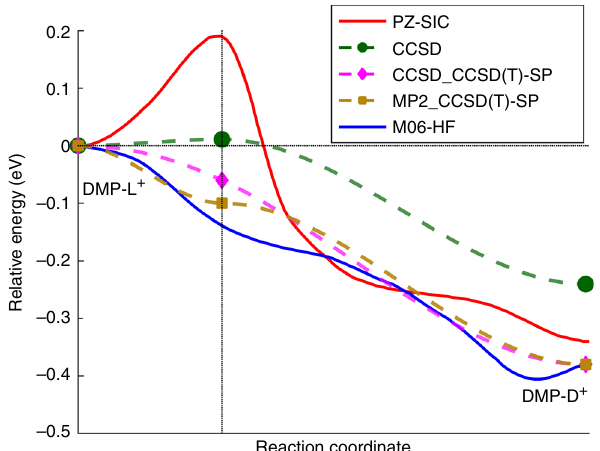
Fig. 1 Calculated potential energy curve between the localized and delocalized state of the dimethylpiperazine cation. The PZ-SIC and M06-HF potential energy curves were obtained from ref. 1 , and the CCSD_CCSD(T)- SP and MP2_CCSD(T)-SP legend labels denote single-point energy calculations that were carried out with the CCSD(T) method using geometry-optimized structures obtained with CCSD and MP2, respectively.